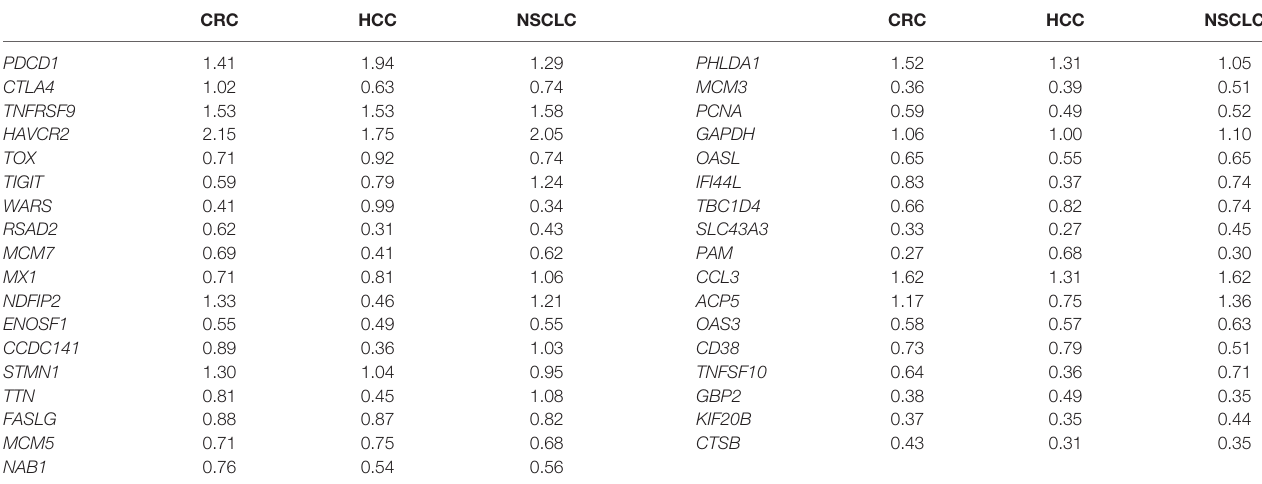
TABLE 1 | The logarithm of fold change of Candidate gene set in three cancers. CRC HCC